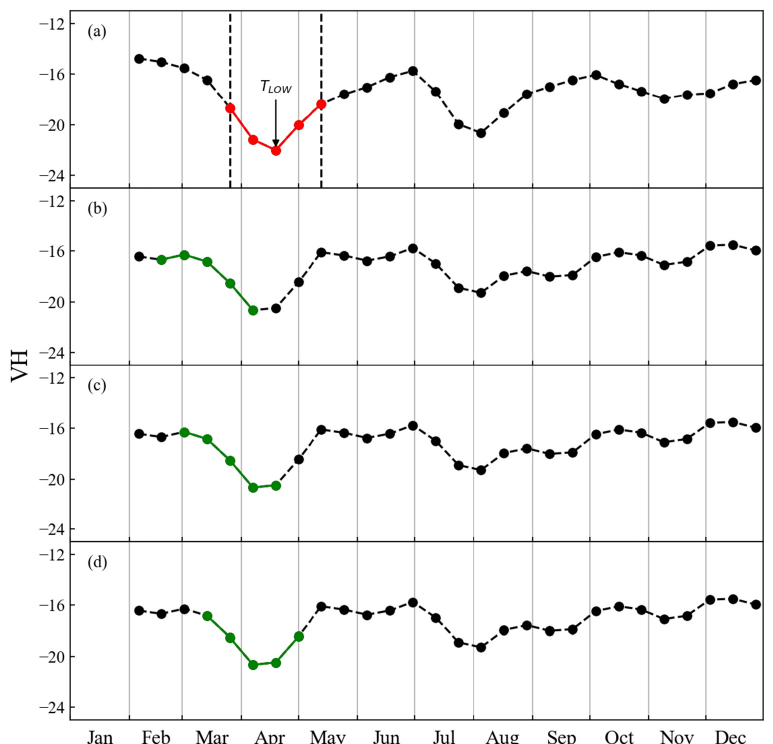
(Figure 4c, green curve), 14 Mar to 1 May (Figure 4d, green curve); we extracted three time series from the same pixel (Figure 4b–d, green curve). Thirdly, based on TWDTW, we calculate the dissimilarity values by comparing the standard curve (Figure 4a, red curve) with each of the three time series (Figure 4b–d, green curve). As a result, we obtained three dissimilarity values. Comparing with 100 standard curves, we calculated a total of 300 dissimilarity values for each unknown pixel, and the lowest dissimilarity value (ERmin) was selected to represent the degree of dissimilarity between the unknown pixels and known early rice pixels.